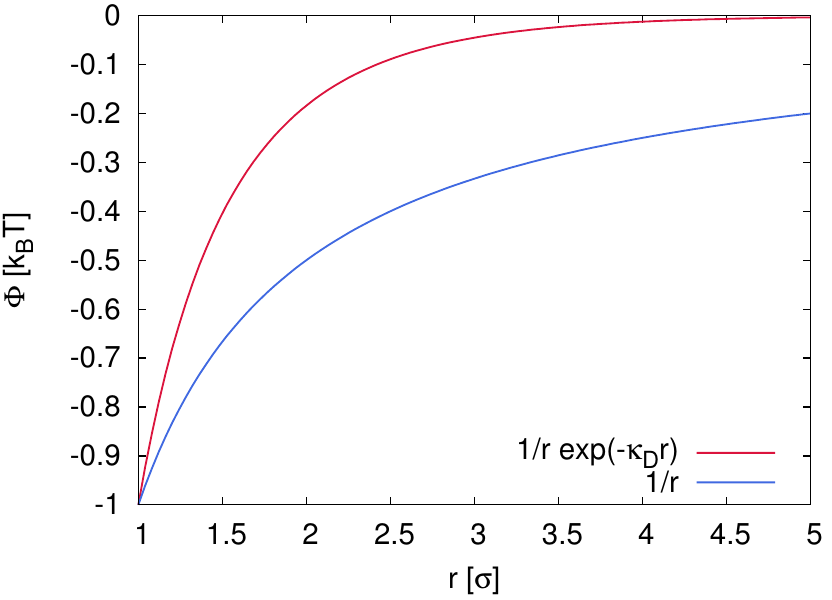
Figure 2. Electrostatic potential Φ ( r ) between two differently charged species at distance r in presence = σ (red line), and for unscreened Coulomb of a finite salt density according to Equation (3) with κ − 1 D interactions with Φ ( r ) ∼ 1/ r (blue line). The electrostatic potential at the hydrodynamic boundary of the object r s = σ is arbitrarily chosen with Φ s = − k B T